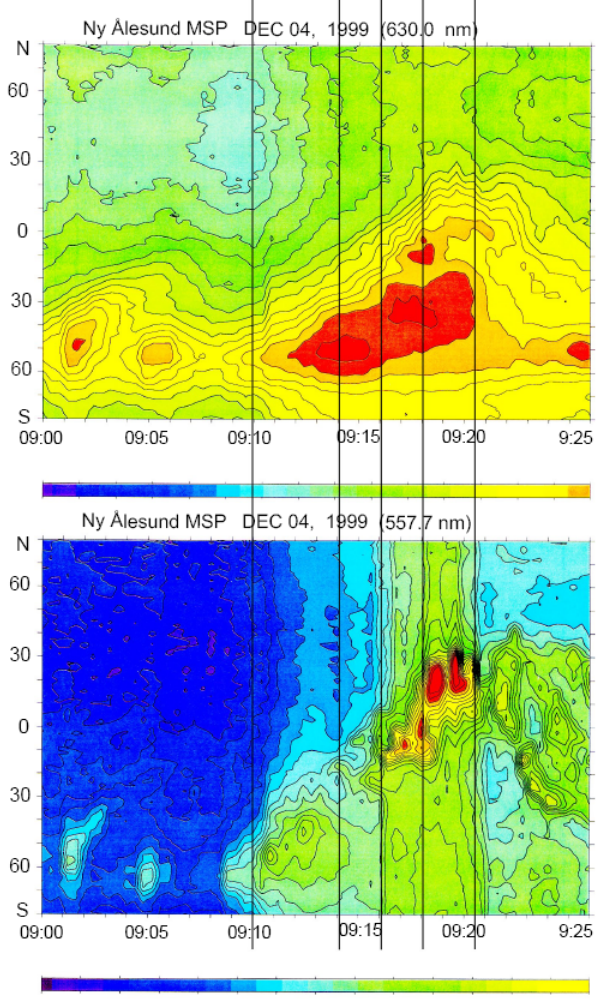
Fig. 12. Ny ˚Alesund MSP data (line-of-sight intensity versus zenith angle) during the interval 09:00–09:26UT. The red and green line intensities are shown in the upper and bottom panels, respectively. Subintervals are marked by vertical